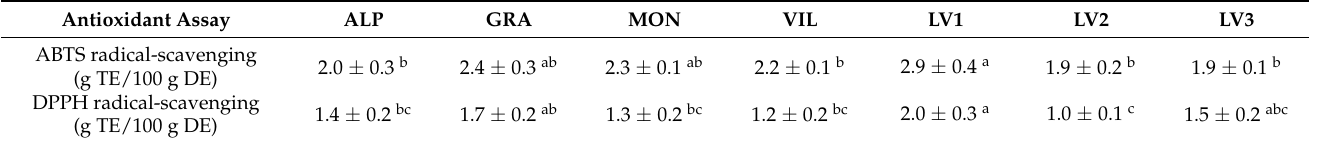
Table 4. Antioxidant properties of the extracts of C. reverchonii